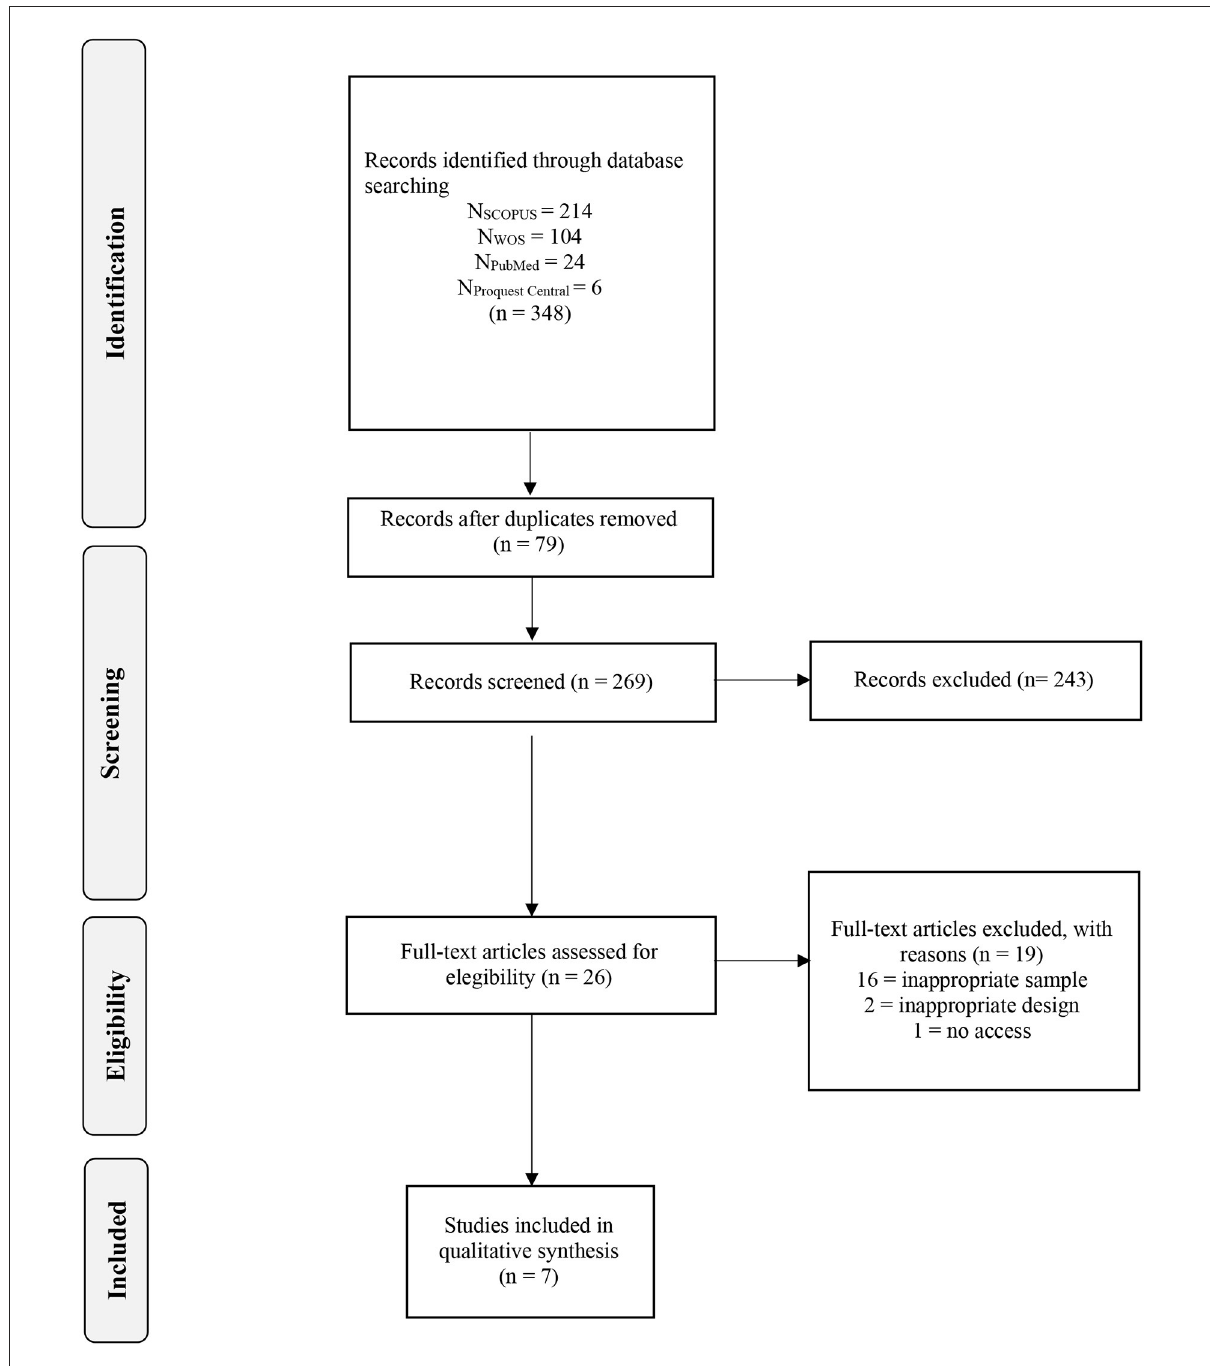
FIGURE1 Flowchart of selection